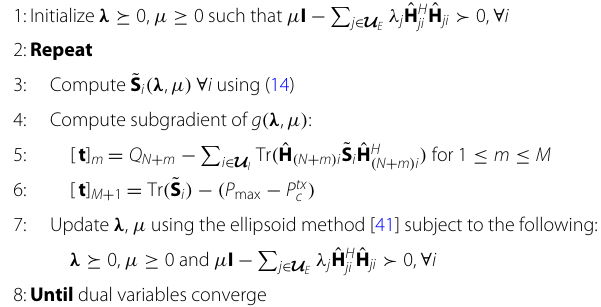
Table 2 Algorithm for solving problem